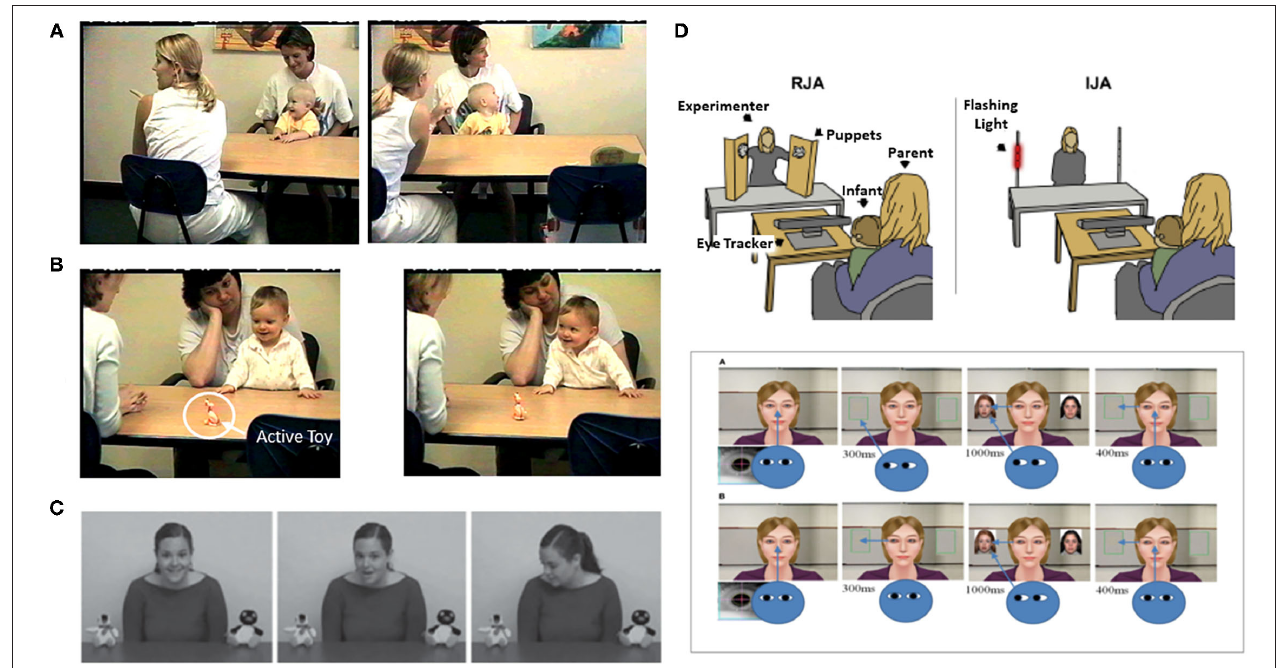
FIGURE 2 | Illustrations of measures of IJA or Initiating Joint Attention/gaze leading [ (B,D,E) upper panels] and RJA or Responding to Joint Attention/Gaze following [ (A,C,E) lower panel] from Gredebäck et al. ( 18), Kim and Mundy (19), Mundy (20), and Nyström et al. (21). Figures reprinted with permissions from, a,b) Child Development, John Wiley, c) Developmental Science, John Wiley, d) Biological Psychiatry, Science Direct, Elsevier, and e) Frontiers in Human Neuroscience, Frontiers.